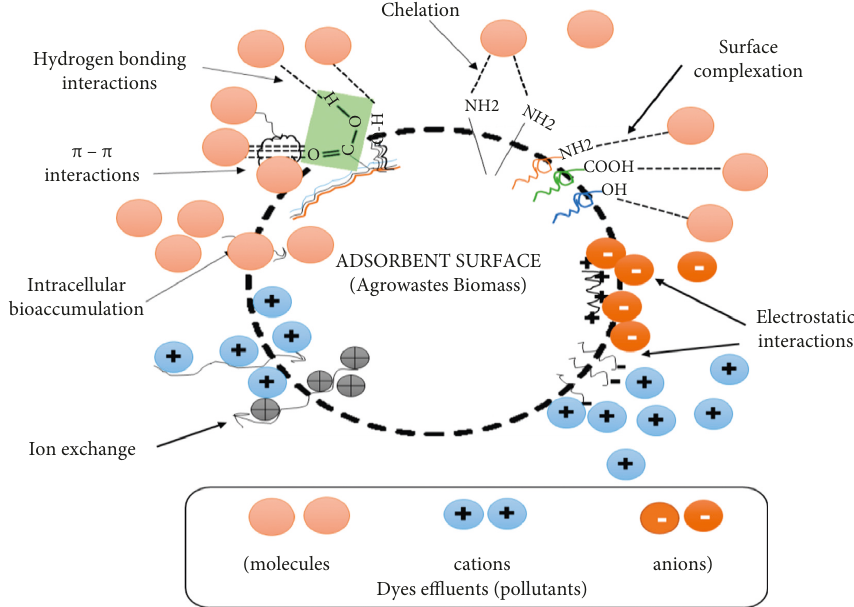
Figure 21: Proposed adsorption interactions between adsorbate and adsorbents are depicted